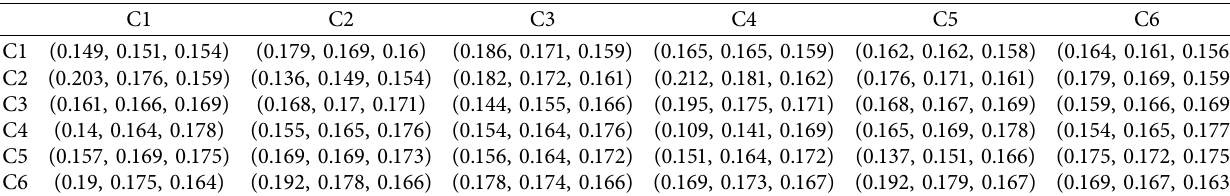
Table 4: Normal correlation matrix of complete dimensions.